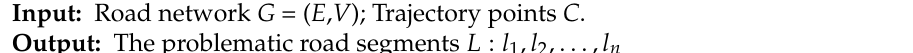
Algorithm 2 Identify and extract problematic road